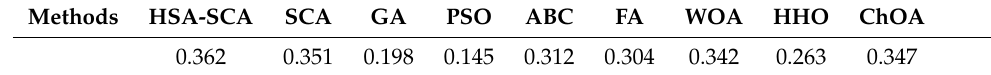
Table 4. Shapiro-Wilk scores for validating the normality condition.